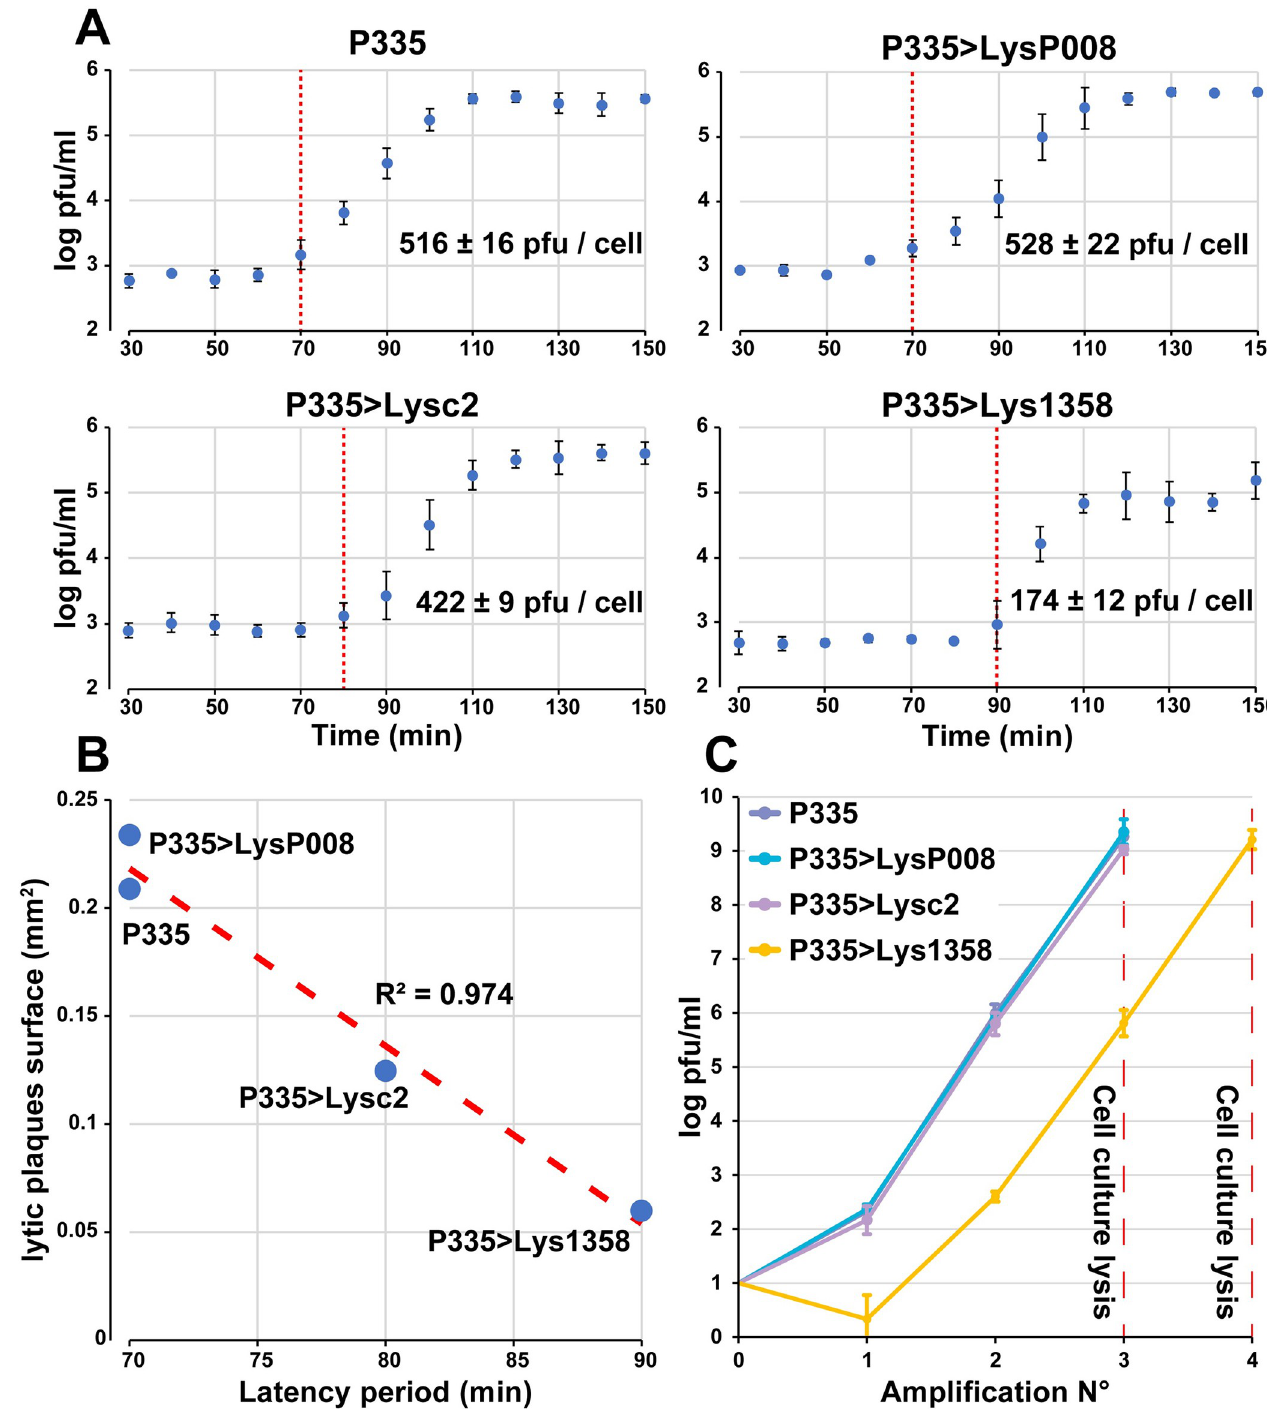
Fig 4. Characterization of the replication parameters of phage P335 and its endolysin mutants. (A) One-step growth curves of phage P335 and the endolysin mutants. The red dashed line indicates the end of the latency period (S1 Data). ( B) Correlation between the mean size of the lytic plaques and the latency period of phage P335 and the endolysin mutants (S1 Data). ( C) Replication dynamics of phage P335 and the endolysin phage mutants. L . lactis IL6288 cells in the exponential growth phase were infected with the different phages at a starting MOI of 0.000001. After the initial phage amplification that occurred during an overnight incubation, the bacteria and phages were transferred into fresh media at a dilution of 1/100 and amplified using the same conditions until clear lysis of the cell culture was observed. Phage titer was measured after each amplification step. Values are means and standard deviations from triplicates (S1